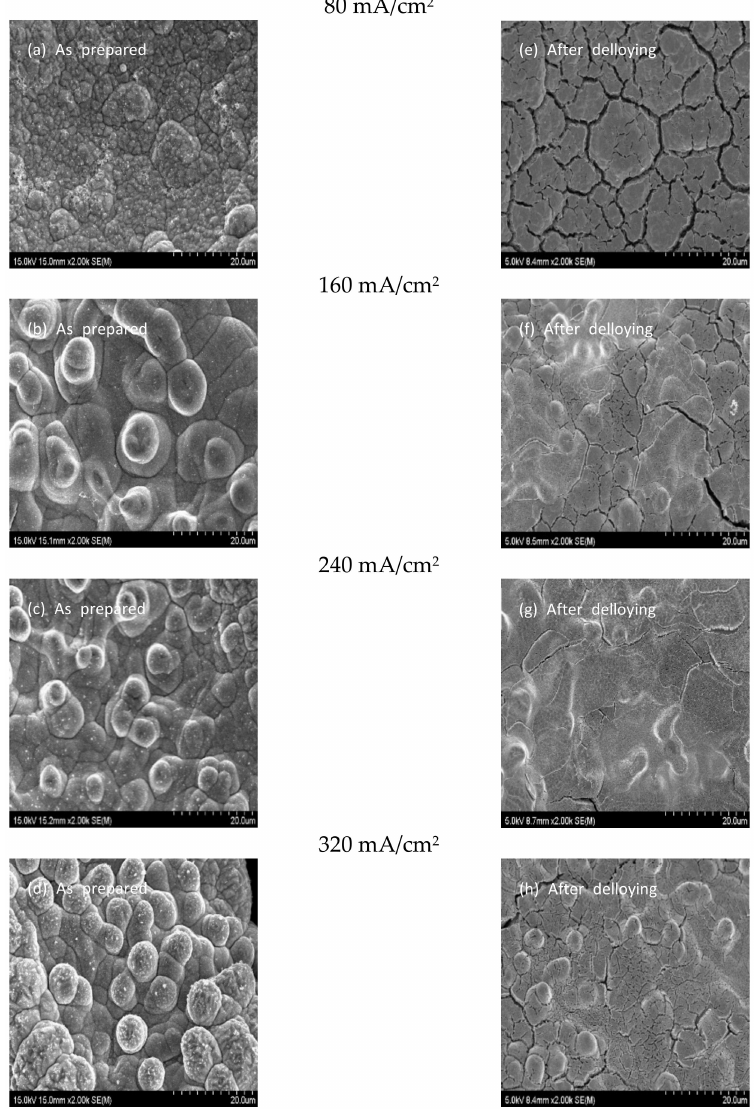
Figure 1. SEM images of electrodeposited Ni–Zn–Fe on a Ni–foam bath E with different current densities ( a – d as prepared, e – h after